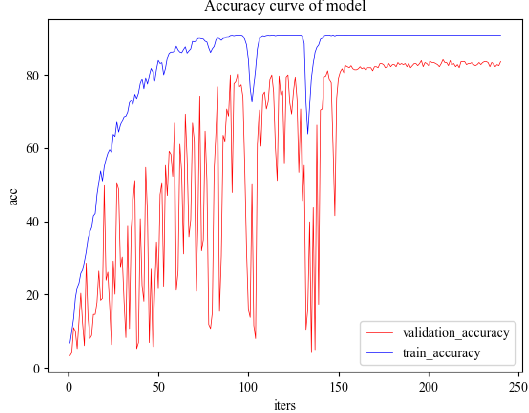
Figure 7. Network accuracy curve. Table 2. 5-fold cross-validation results.